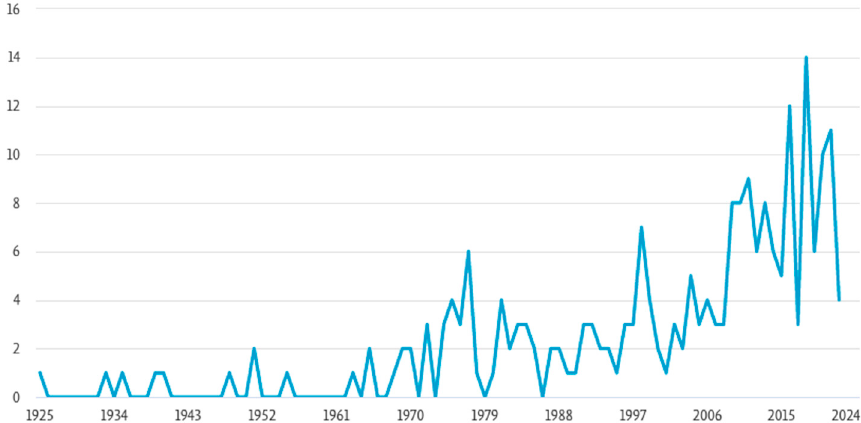
Figure 2. Number of publications per year (ordinate and abscissa axes, respectively) devoted to polychlorides (19 December 2022; Scopus database, search TITLE-ABS-KEY (polychloride *)—222 examples).